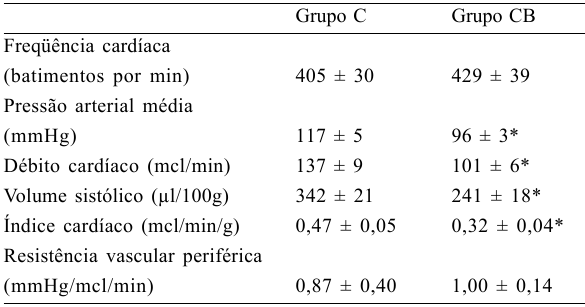
Tabela 4. Resultados do estudo hemodinâmico, em animais dos grupos C e